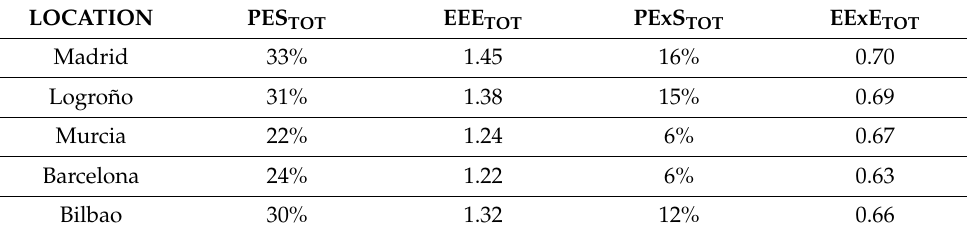
Table 3. Energy and exergy polygeneration indicators.